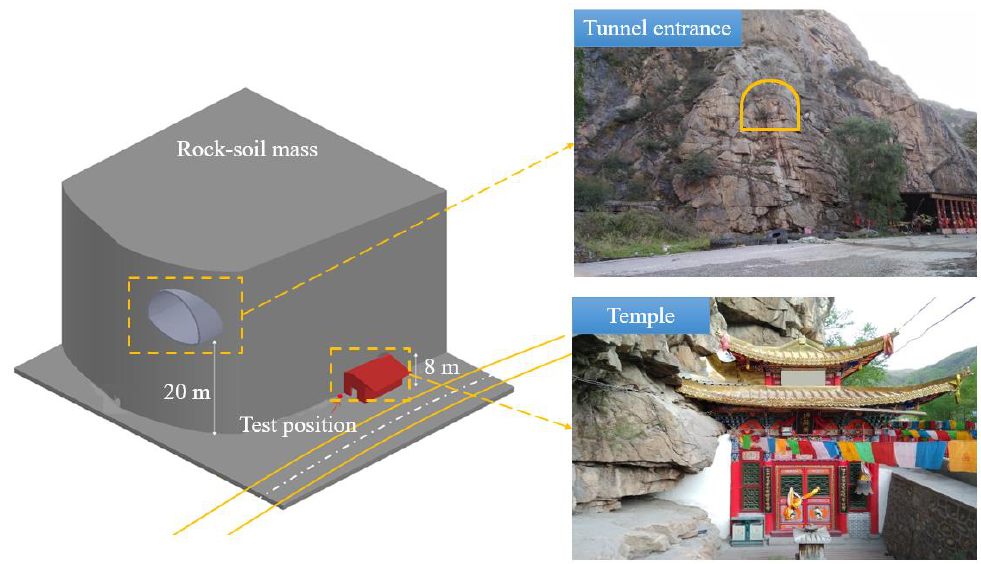
Figure 2. Route map of the tunnel (via Google Earth Pro).